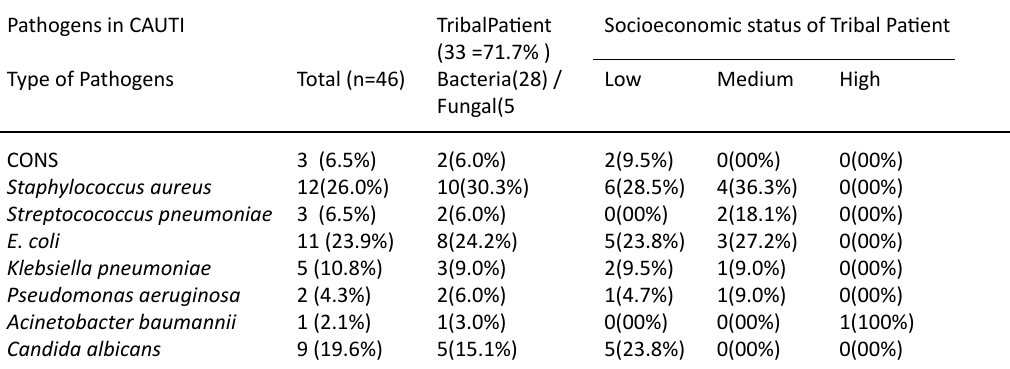
Table 3. Spectrum of Pathogens according to Type of Patients in the MICU Pathogens in CAUTI